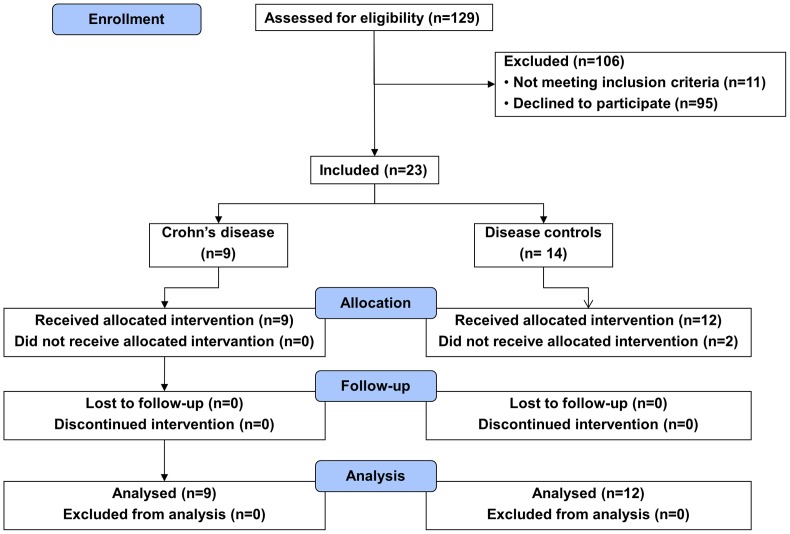
Flowchart of patient inclusion in the study.